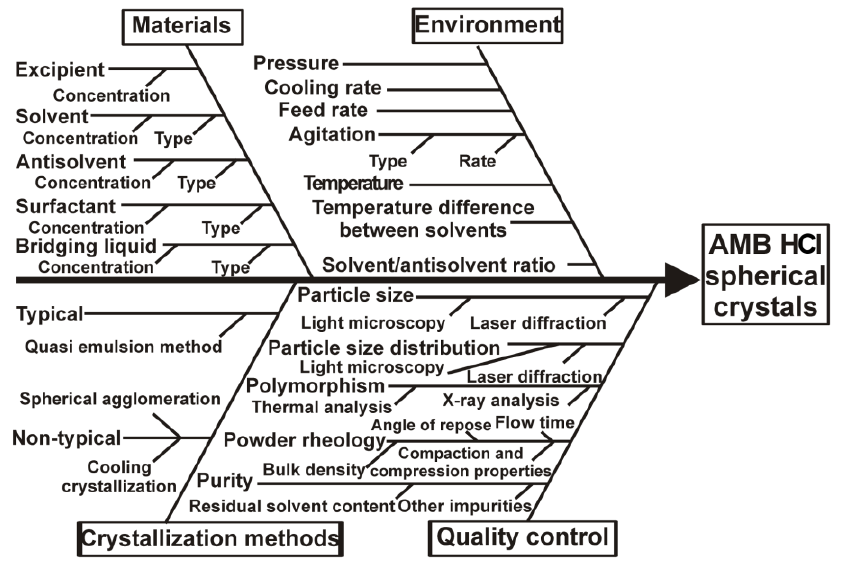
Figure 2. Isikawa diagram for the identification of the key parameters for the production of spherical ambroxol hydrochloride (AMB HCl) agglomerates.